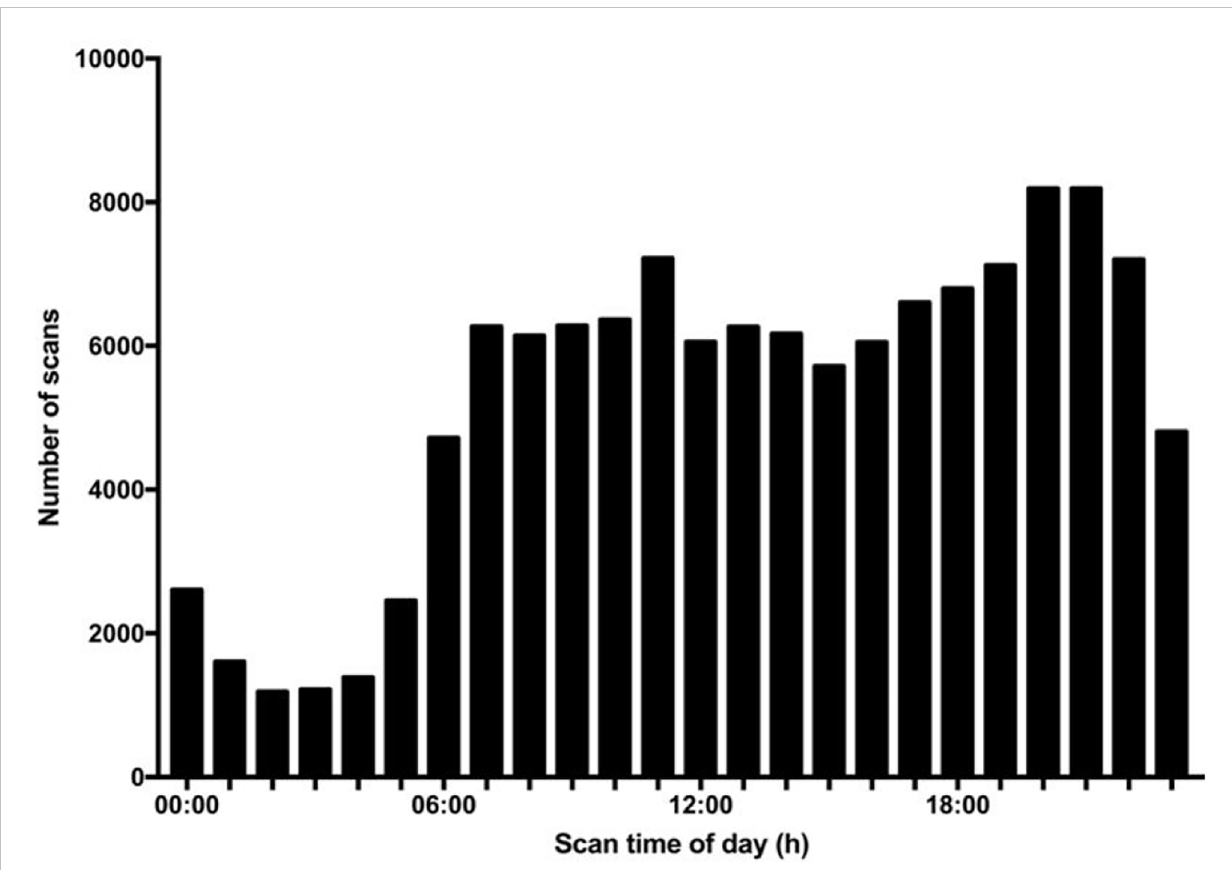
FIGURE 4 Glucose monitoring frequency in a study of the ef fi cacy of unblinded and blinded intermittently fl ash continuous glucose monitoring on glycemic control in adults with type 1 diabetes. Total number of scans by time of day in the unblinded